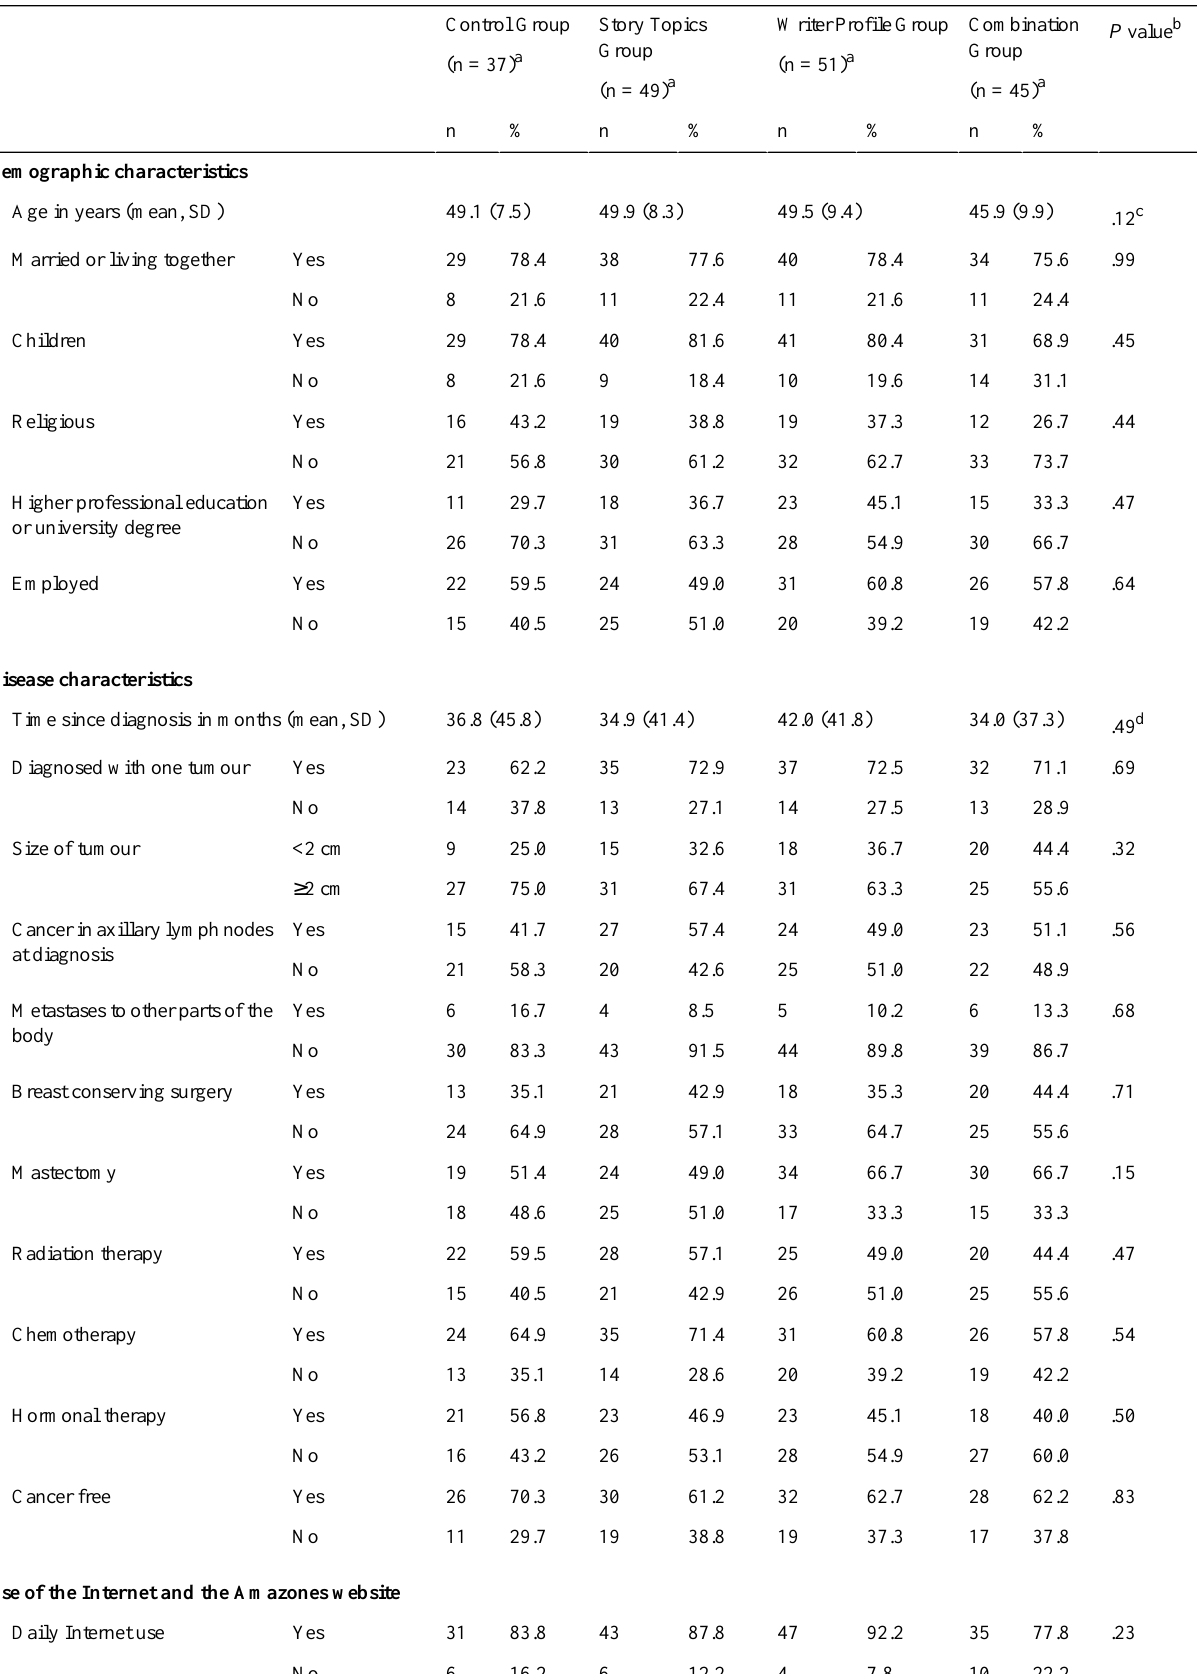
Table 3. Baseline characteristics of the four